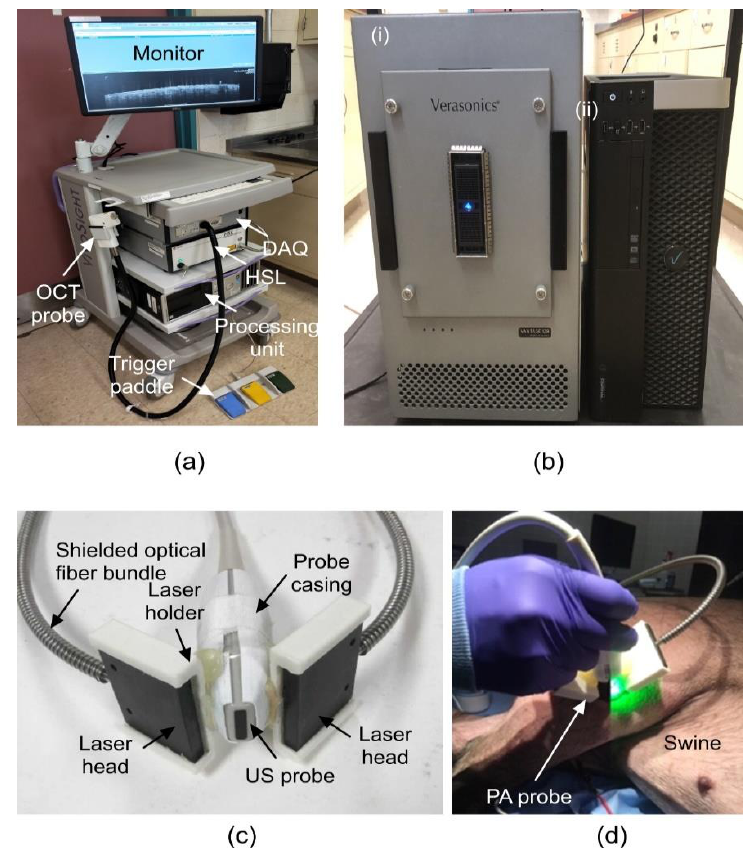
Figure 2. Ultrasound (US) / photoacoustic (PA) system components. ( a ) Optical coherence tomography (OCT) system. ( b ) US / PA DAQ, processing, and storage units, (i) Vantage 128 DAQ system, and (ii) processing unit. ( c ) US / PA probe specifications. ( d ) US / PA probe in use on swine melanoma